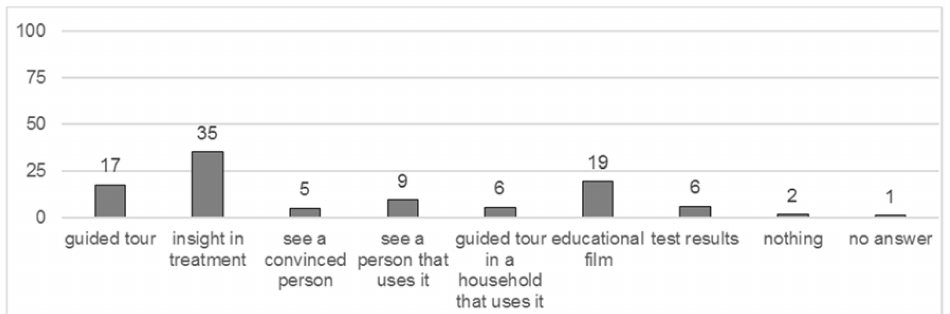
Figure 4. Q4 “What would convince you the most of the high-quality of drinking water that was directly purified from waste water? Choose from the given options or add a new one.” N Students = 340, N Statements = 706. All statements add up to 100%. “Test results” was the only relevant answer added by participants. All other listed options were already